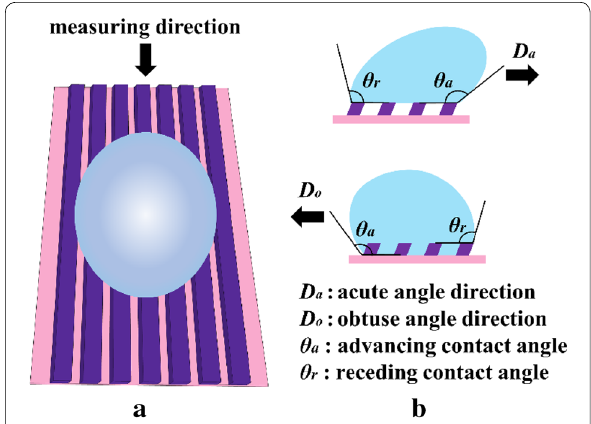
Fig. 3 Schematic views of a CAs measurement direction seen from goniometer, and b dynamic CAs